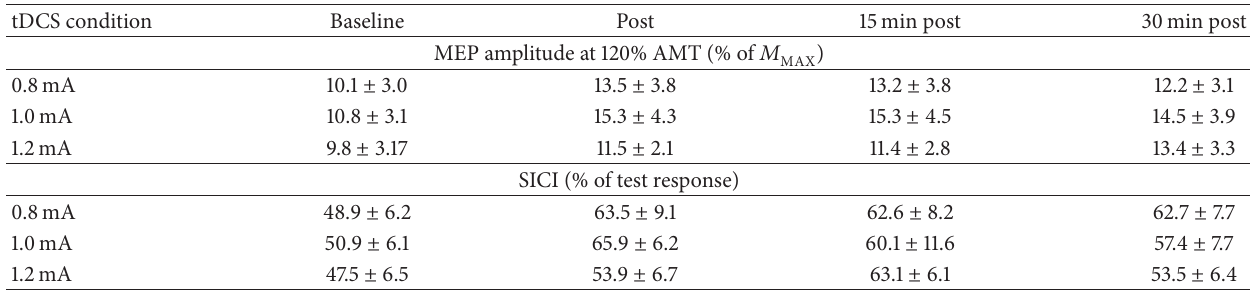
Table 2: Mean ± SE cortical excitability and short-interval intracortical inhibition (SICI) responses following anodal tDCS: MEP amplitude ), and conditioned MEP amplitudes as a percentage of the test response (SICI ratio). at 120% AMT as a percentage (% of 𝑀 MAX